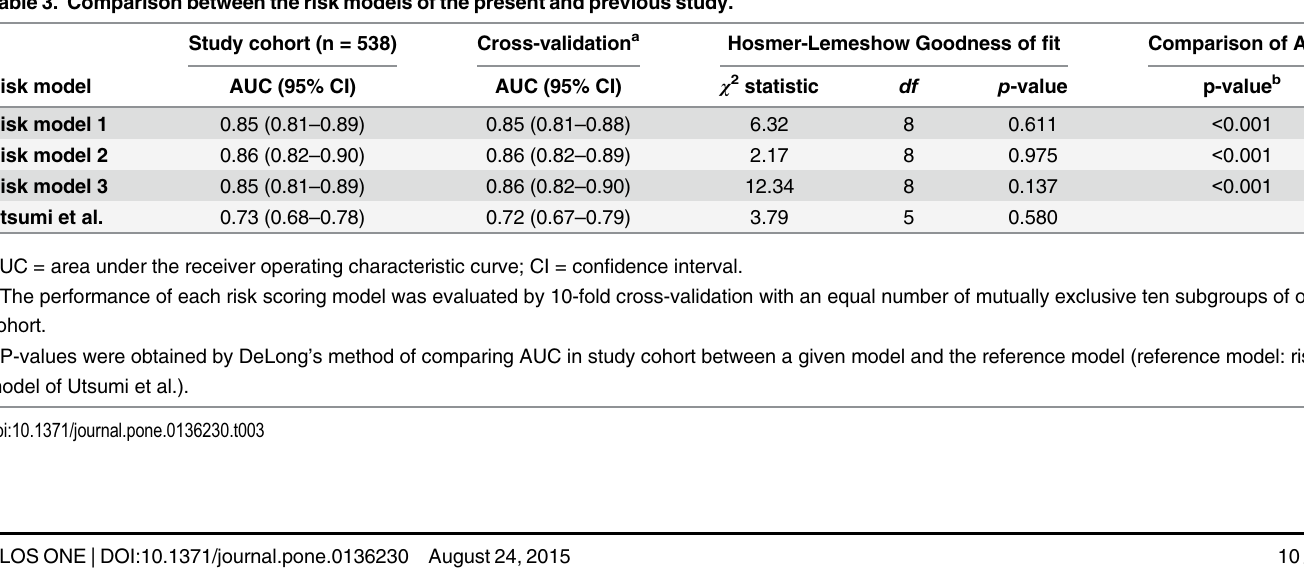
Table 3. Comparison between the risk models of the present and previous study.